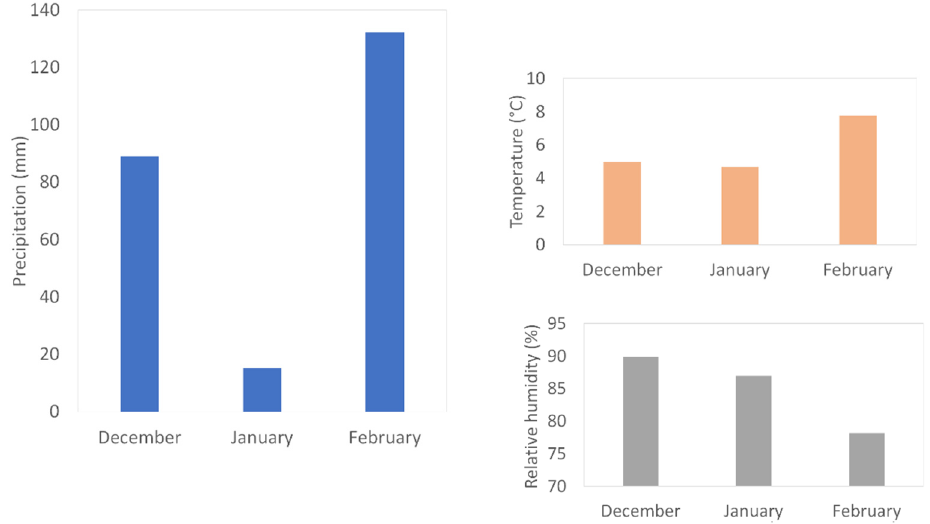
Figure 2. Monthly meteorological data over the measurement period.